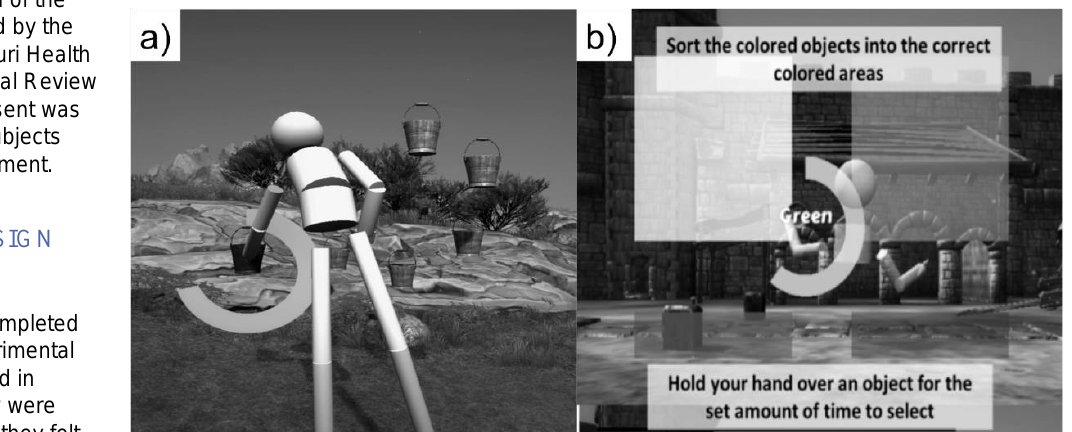
Figure 4a. The simple reaching task. Figure 4b. The sorting